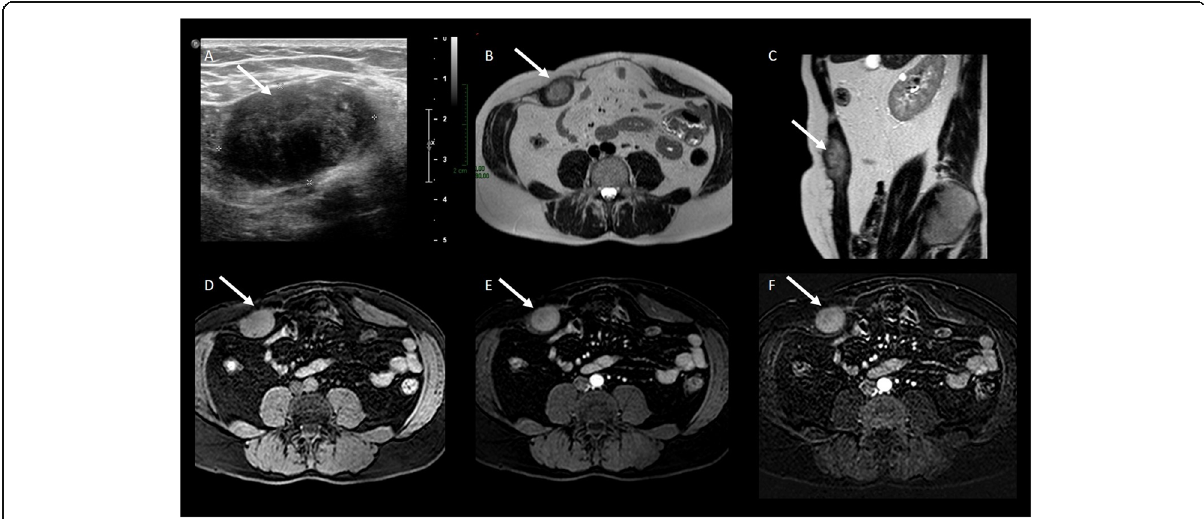
Fig. 16 DT of the abdominal wall. a US examination showed a well-defined mass in the right rectus muscle. At MRI, the lesion is characterized by hyperintense signal on T2wi ( b , c ), isointense signal with the muscle on T1wi ( d ), and homogeneous enhancement on T1wi after contrast agent administration ( e ) especially on subtracted imaging ( f